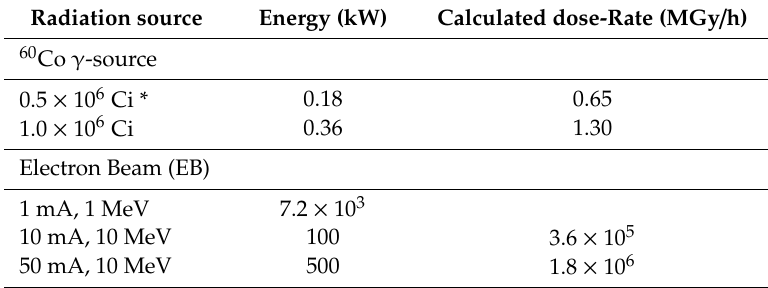
Table 2. Achievable (measured) dose-rates of Gamma and EB radiation sources [4].